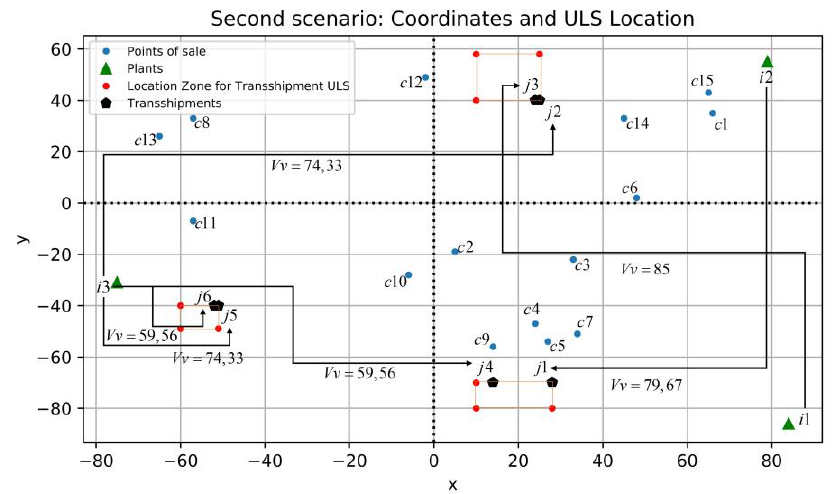
Figure 7. Pareto frontier for the second scenario.